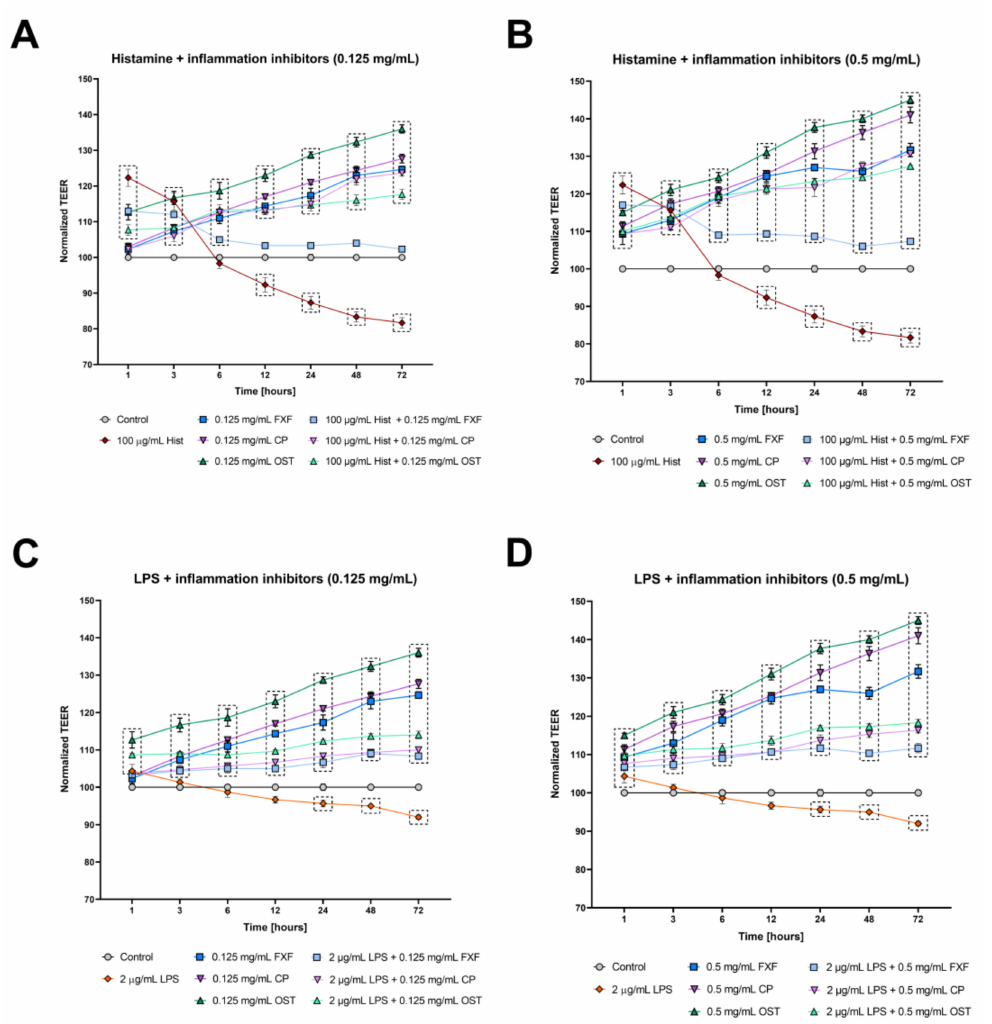
Figure 4. Changes in integrity of cultured cells monolayer measured by TEER in the organotypic 3D skin model after incubation with histamine (Hist; A , B ) lipopolysaccharide (LPS; C , D ), fexofenadine (FXF), clobetasol propionate (CP) and osthole (OST), and mixtures of histamine and LPS with FXF, CP and osthole. Symbols indicate mean and bars indicate standard error of the mean. Statistically significant differences ( p < 0.05, two-way ANOVA with Dunnett’s multiple comparisons test) are shown in rectangles with dotted